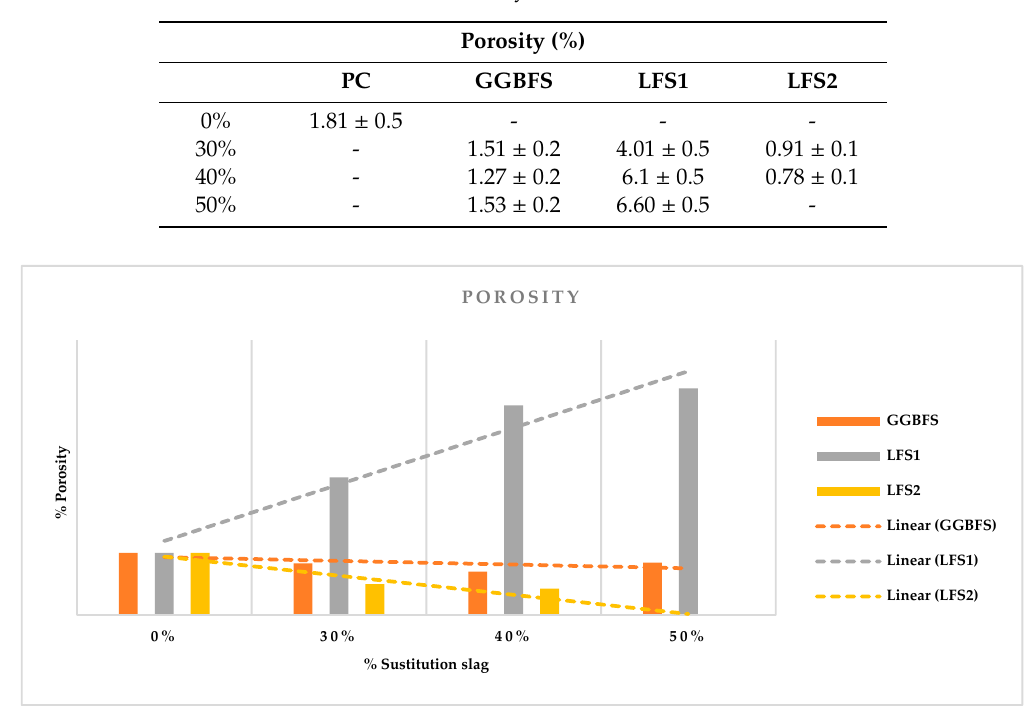
Figure 2. Porosity. Figure 2.